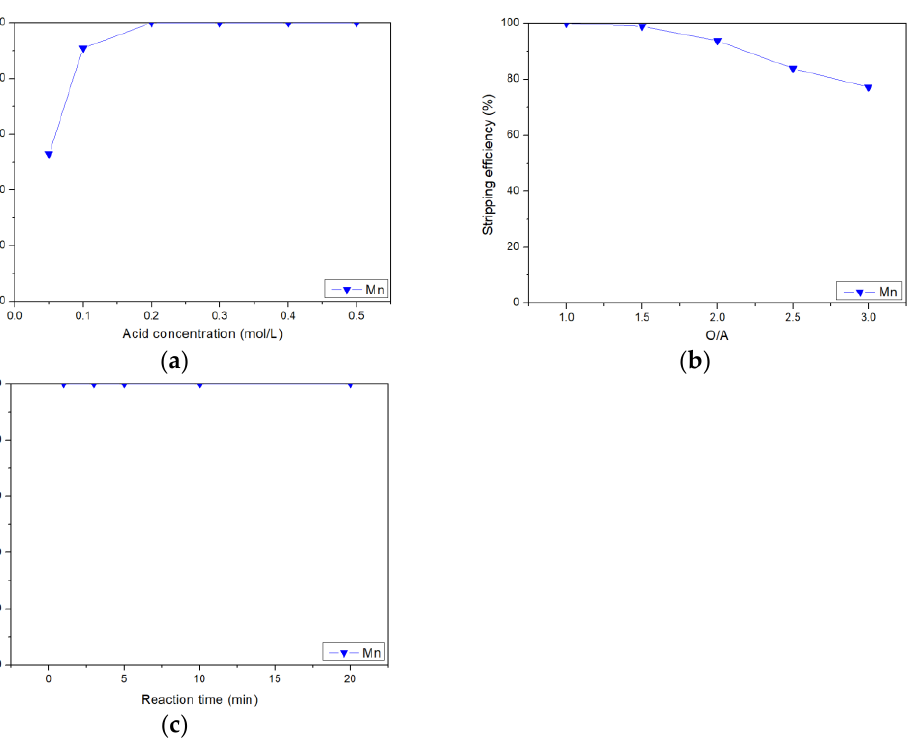
Figure 3. Effects of ( a ) acid concentration (O/A = 1, t = 15 min), ( b ) oil – water ratio ([H 2 SO 4 ] = 0.2 M, t = 15 min), and ( c ) reaction time ([H 2 SO 4 ] = 0.2 M, O/A = 1.5) on manganese stripping.